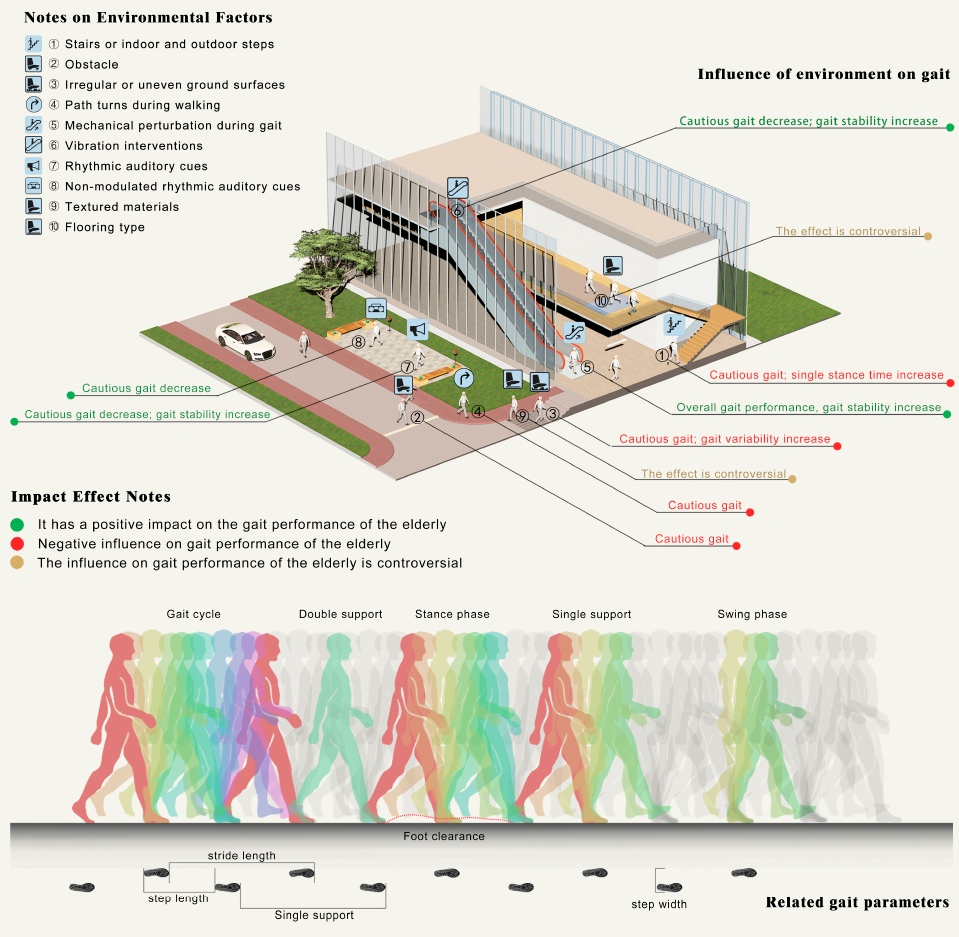
Figure 4. The influence of human settlements environment on the gait of the older people and the description of relevant gait parameters.